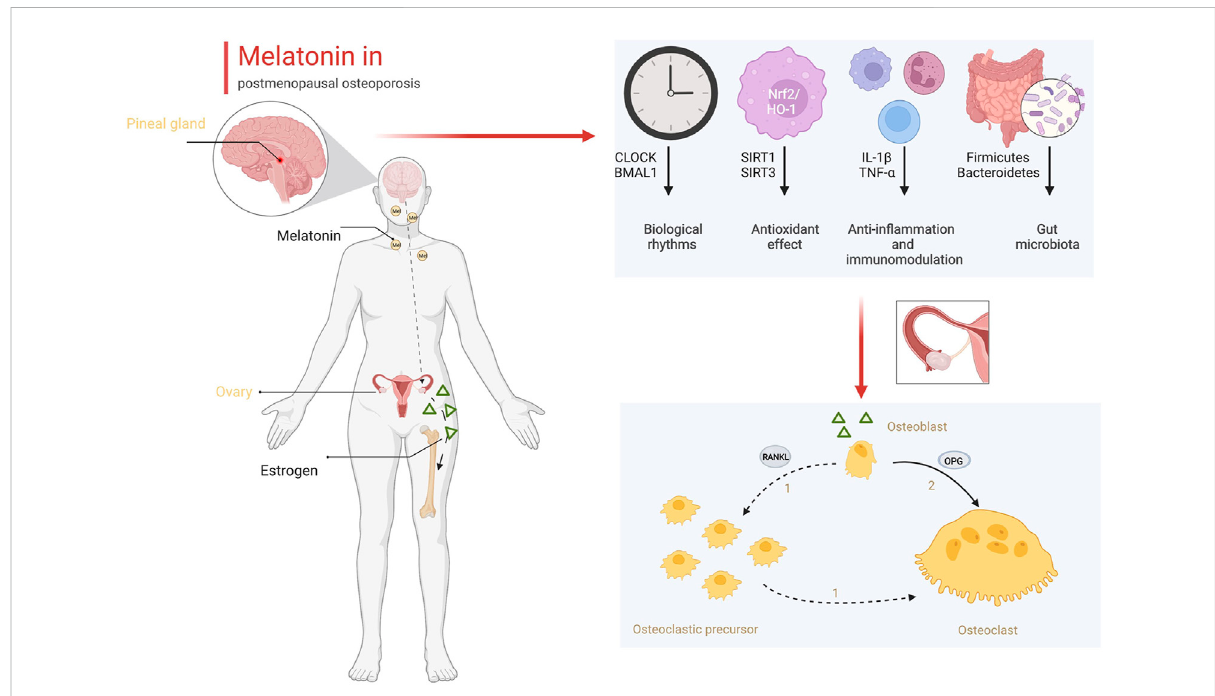
FIGURE 2 The role of melatonin in bone metabolism (Created with